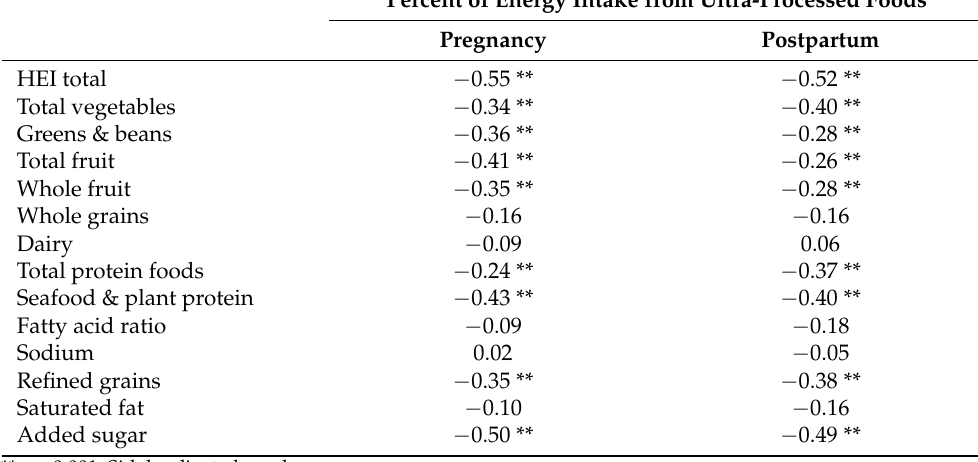
Table 2. Pearson correlations of ultra-processed food intake with Healthy Eating Index 2015 (HEI) total and component